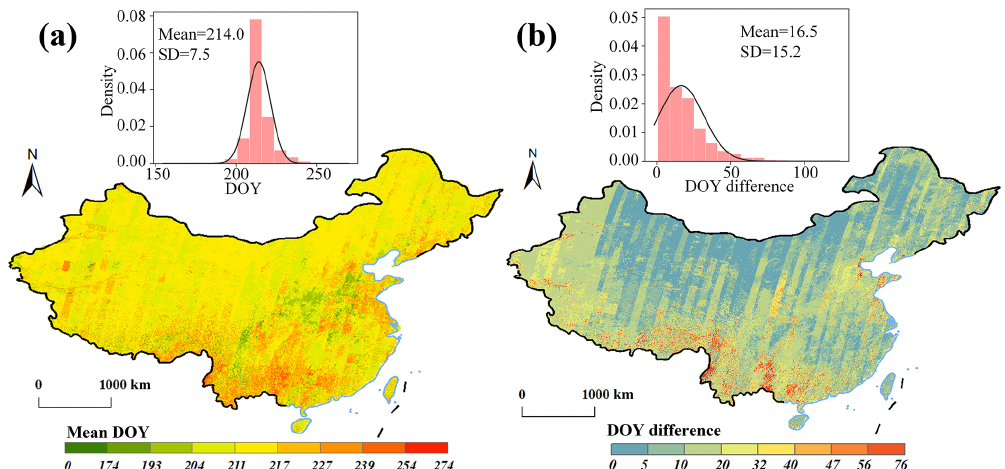
Figure 13. The mean DOY of each pixel in the BAP composites from 1985 to 2020 and (a) the maximum DOY difference of each pixel location in the BAP composites from 1985 to 2020 (b) . Note: SD – standard